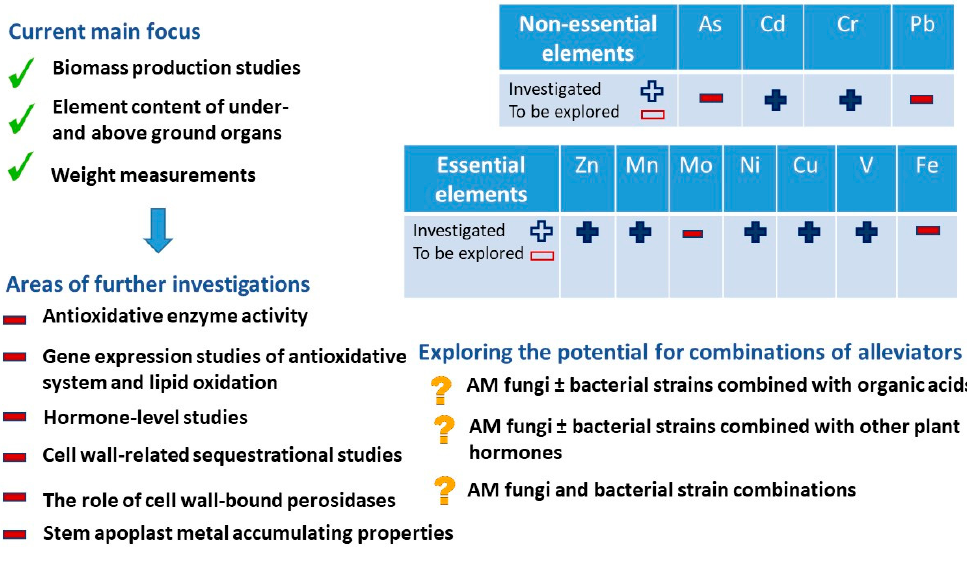
Figure 5. Current status and developmental possibilities of HM alleviation investigations .